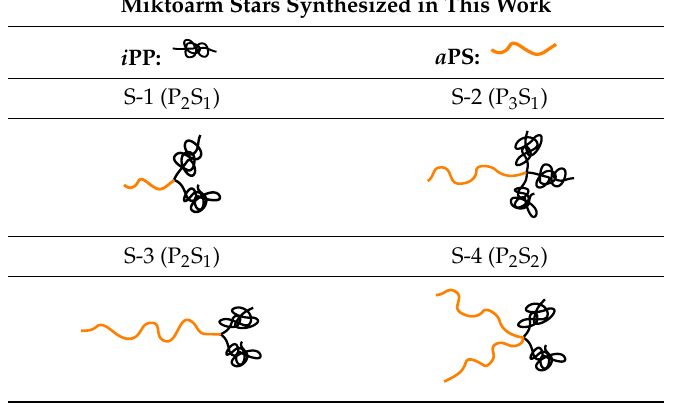
Figure 4. GPC-LS curves of i PP/ a PS miktoarm star copolymers (eluent: 1,2,4-trichlorobenzene; temperature: 150 ◦ C). Table 3. Schematics of miktoarm star copolymers P x S y with different lengths of soluble a PS arms in selective solvent DMF.